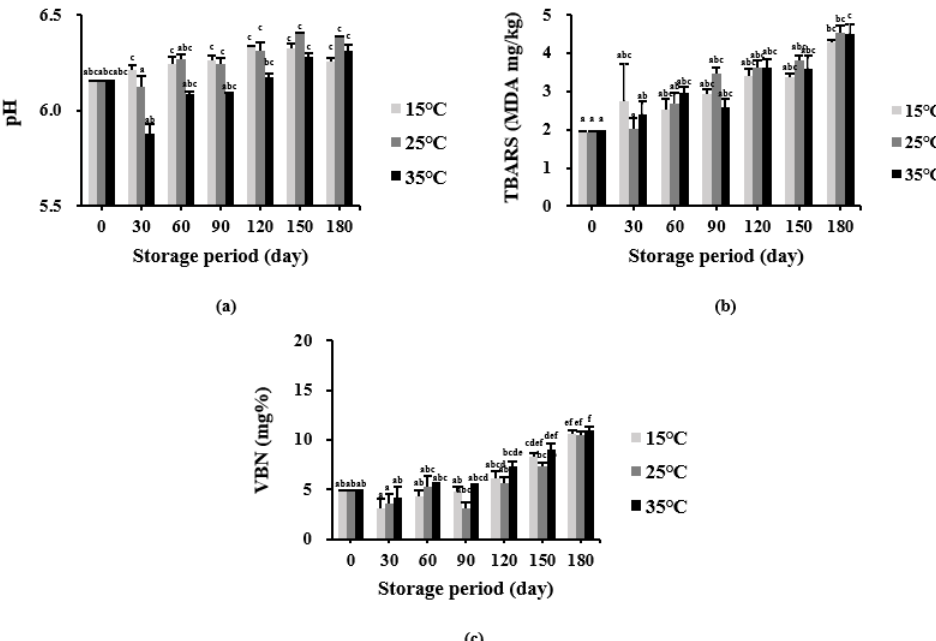
Figure 6. Chemical quality parameters of the puffed-rice snack enriched with drone pupae powder at different storage temperatures (15 °C, 25 °C, and 35 °C) for 180 days: ( a ) pH values; ( b ) TBARS values; ( c ) VBN values. Values are mean ± SD. Different letters (a – f) in the respective columns indicate significant differences among the means by the Tukey’s test ( p < 0.05). Table 17. Changes in the total bacteria count (TBC), E. coli , and total coliform group (TCG) in the puffed-rice snack enriched with drone pupae powder at different storage temperatures (15 ◦ C, 25 ◦ C, 35 ◦ C) for 180 days.